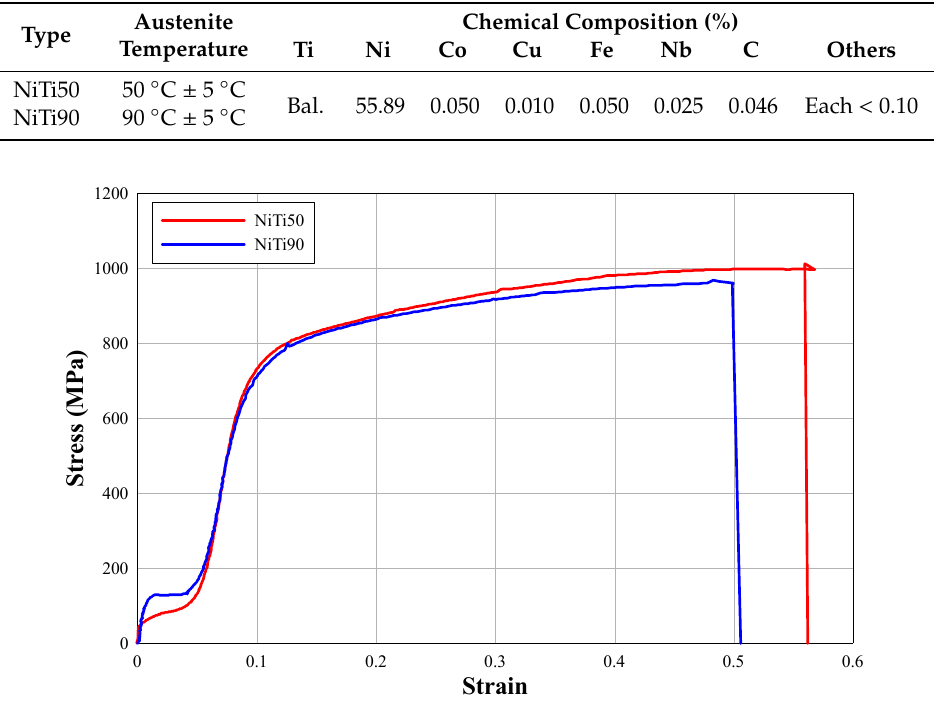
Table 1. Material properties of the SMA wire, as provided by the manufacturer.